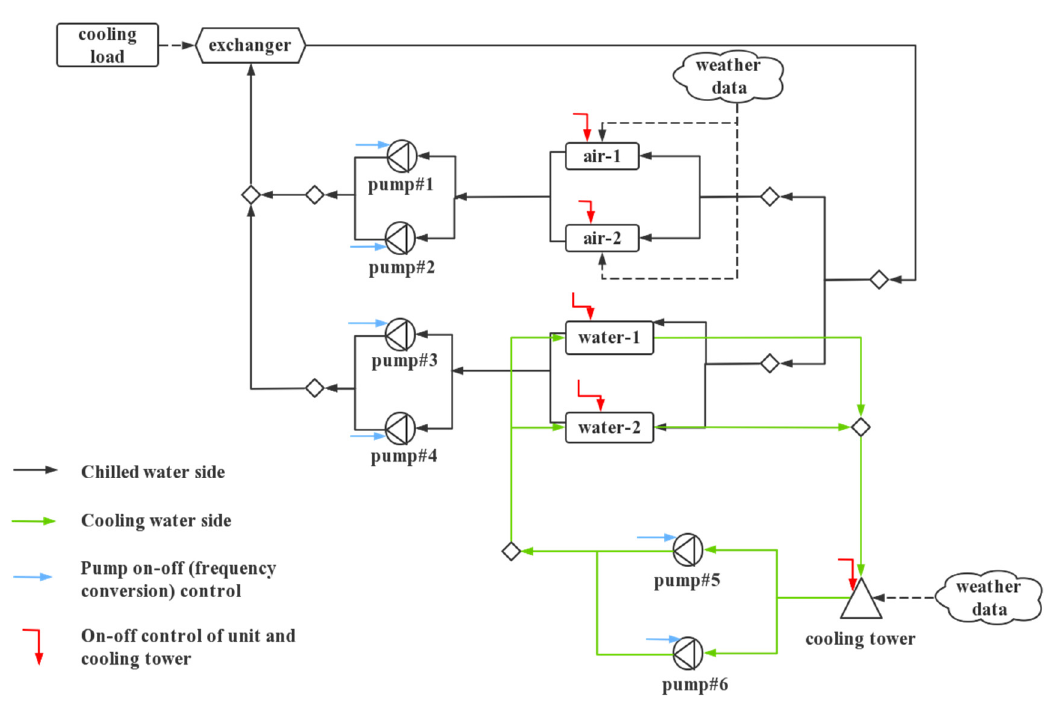
Figure 6. The schematic diagram of the refrigeration system. Table 2. Comparisons of operation schemes of the refrigeration